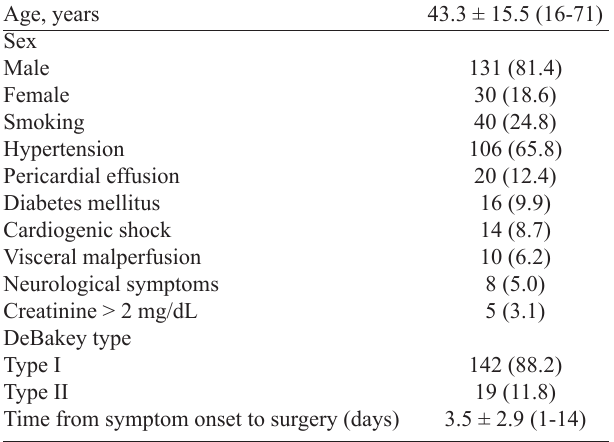
Table 1. Patient demographic and clinical characteristics (N =